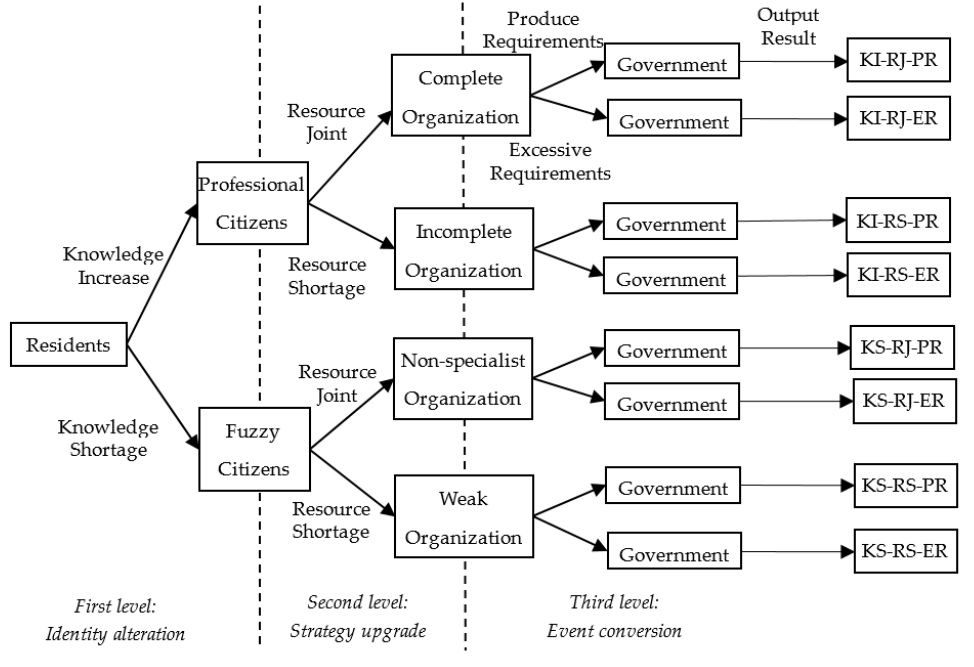
Figure 7. The rule tree based on hierarchical theory